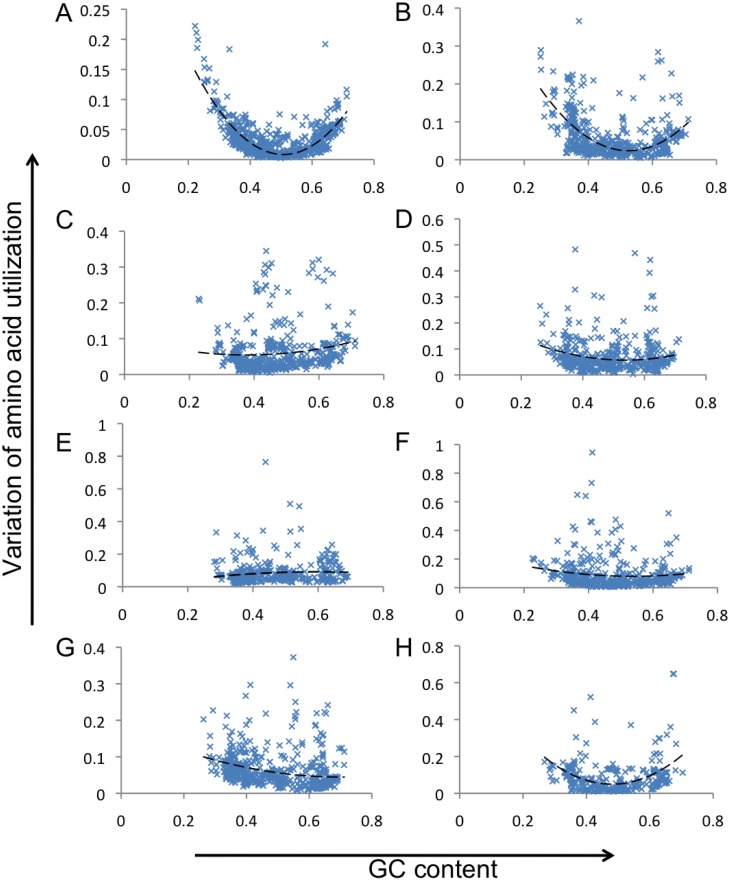
Comparison of KLD and GC-content for all phage genomes.(A), and for individual groups of subsystems (B–H). The GC content of each genome is plotted on the x-axis, and the variation in amino acid composition is shown on the y-axis. The correlation equation for A–complete phage genomes is y = 1.7x2 − 1.7x + 0.44, and the correlation coefficient R2 = 0.63. In (B), the skews are only shown for those proteins in the phage replication subsystems, and the equation is 2.2x2 − 2.3x + 0.6, with a correlation coefficient = 0.3. In (C), the skews are only shown for those proteins involved in the capsid subsystems, and the representative equation is 0.34x2 − 0.26x + 0.1, with a correlation coefficient = 0.025. In (D), the skews are only shown for those proteins involved in phage head, and the equation is 0.739x2 − 0.79x + 0.27, with a correlation coefficient = 0.029. In (E), the skews are only shown for proteins in subsystems involved in phage lysis, and the equation is −0.31x2 + 0.37x − 0.189, with a correlation coefficient = 0.01. In (F), the skews are only shown for those proteins in experimental subsystems (mostly uncharacterized proteins), and the equation is 0.65x2 − 0.7x + 0.26, with a correlation coefficient = 0.01. In (G), the skews are only shown for those proteins involved in phage tail subsystems, and the equation is 0.285x2 − 0.4x + 0.1856, with a correlation coefficient = 0.095. In (H), the skews are only shown for those proteins in phage tail fiber subsystems, and the equation is 3.2x2 − 3.09x + 0.79, with a correlation coefficient = 0.15.